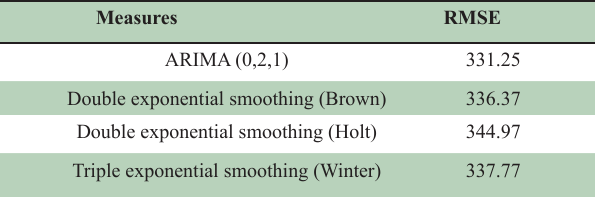
Table-III: Detail of accuracies measures under fitted